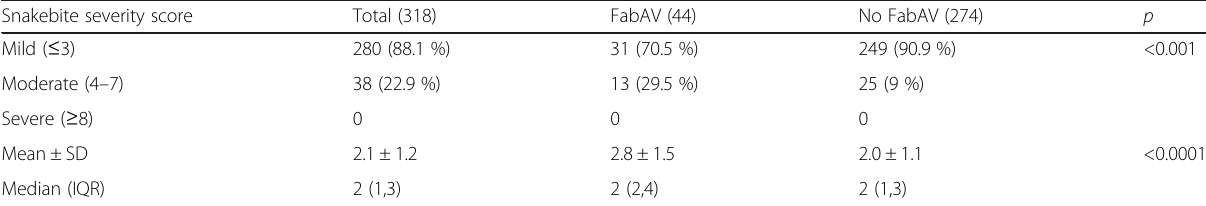
Table 3 Snakebite severity score Snakebite severity